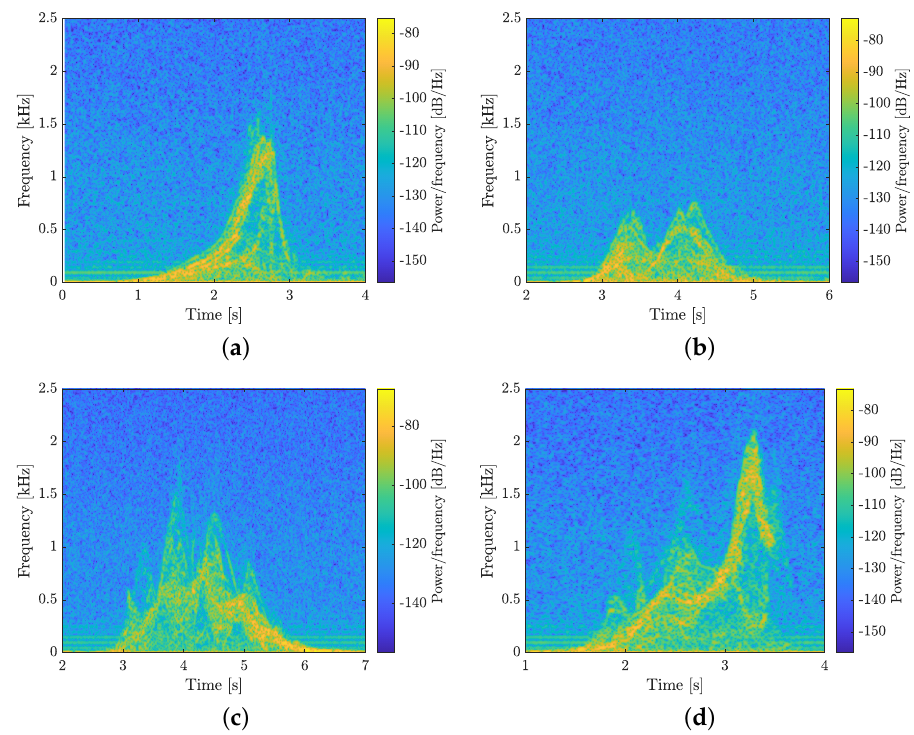
Figure 6. Spectrogram of the micro-Doppler frequencies for the evaluated movements of a test subject: ( a ) falling; ( b ) sitting; ( c ) walking; ( d ) falling while walking.